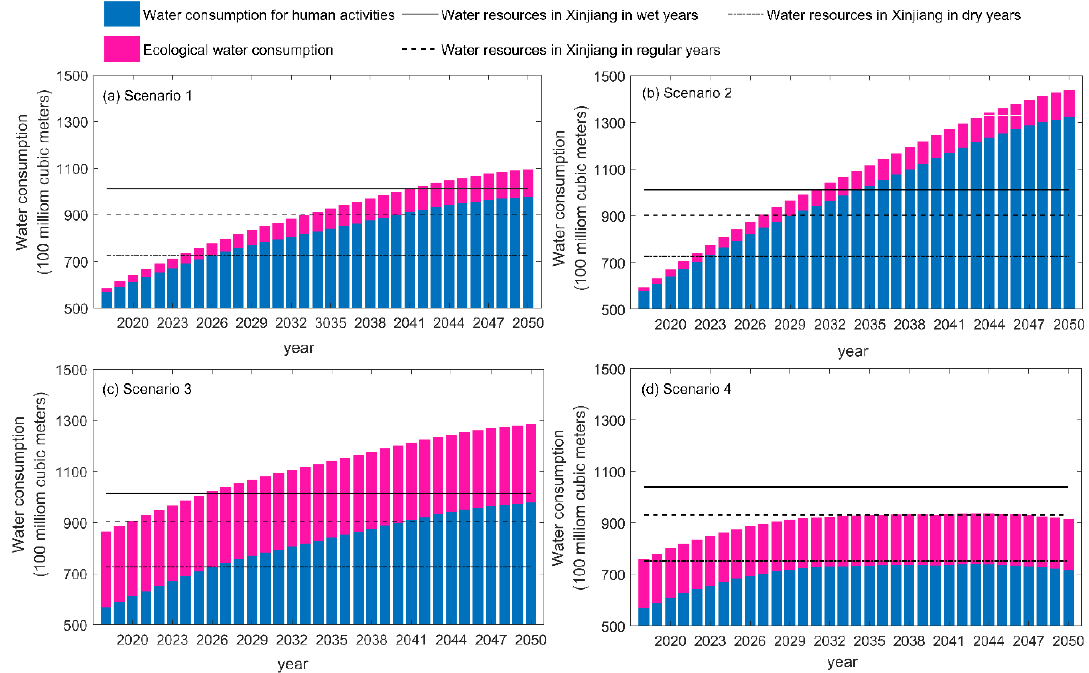
Figure 6. The future water consumption in Xinjiang under different scenarios. The blue rectangle represents water consumption for human activities and red rectangle represents ecological water consumption. ( a – d ) are water consumption under scenario 1, scenario 2, scenario 3, and scenario 4, respectively.